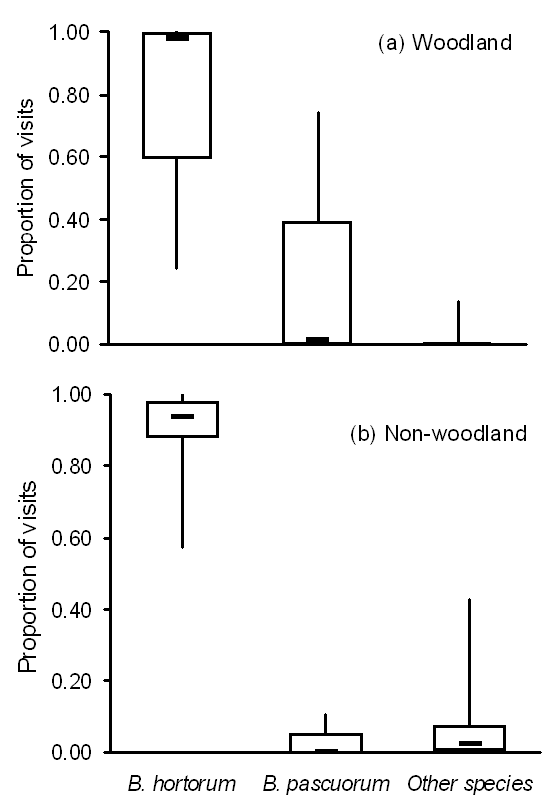
F IGURE . 1. Proportion of visits to Digitalis purpurea by Bombus hortorum , B. pascuorum and other insect species in (a) woodland habitat and (b) non-woodland habitat. Median denoted by horizontal bar, quartiles by box and range by vertical lines. Per- patch mean (range) total numbers of insect visits were 66.8 (24 - 134) for woodland and 101.4 (15 - 241) for non-woodland habitat ( n = 10 D. purpurea patches per habitat). Other species consisted of Apis mellifera , Bombus lapidarius , B. terrestris / B. lucorum (pooled), Megachilidae, Syrphidae, Vespula spp. and other Vespidae. D ISCUSSION